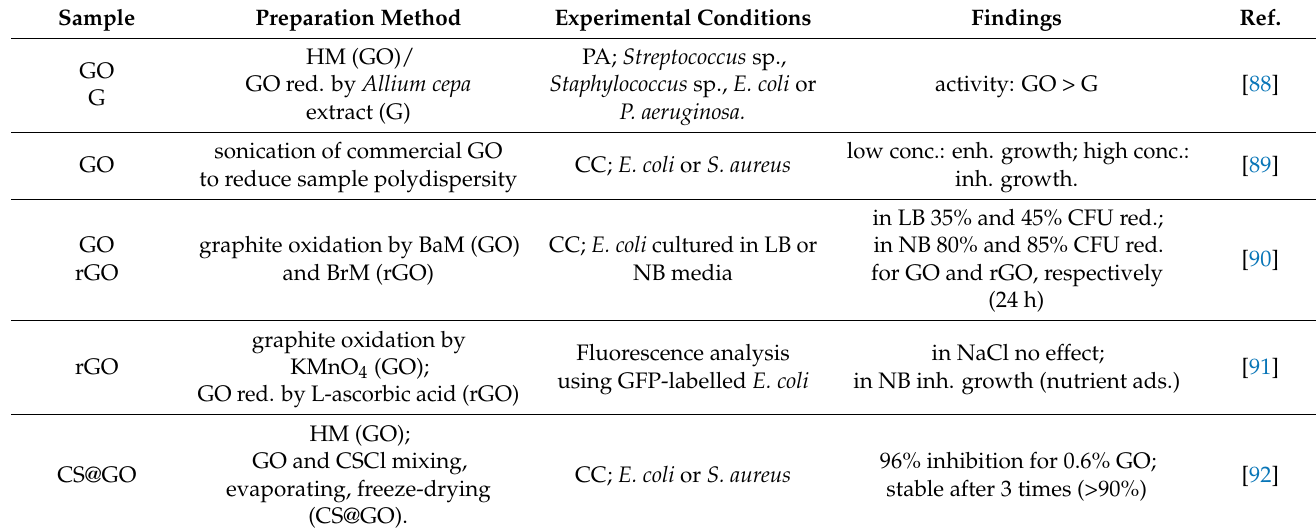
Table 2. Graphene compounds for microbial